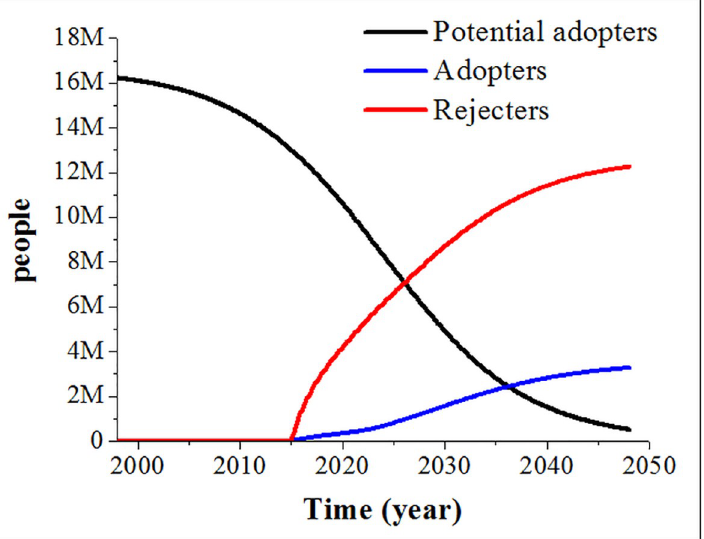
Fig 3. Base run model behaviour showing changes in the main stocks of the model on insect-based food adoption in the Netherlands.